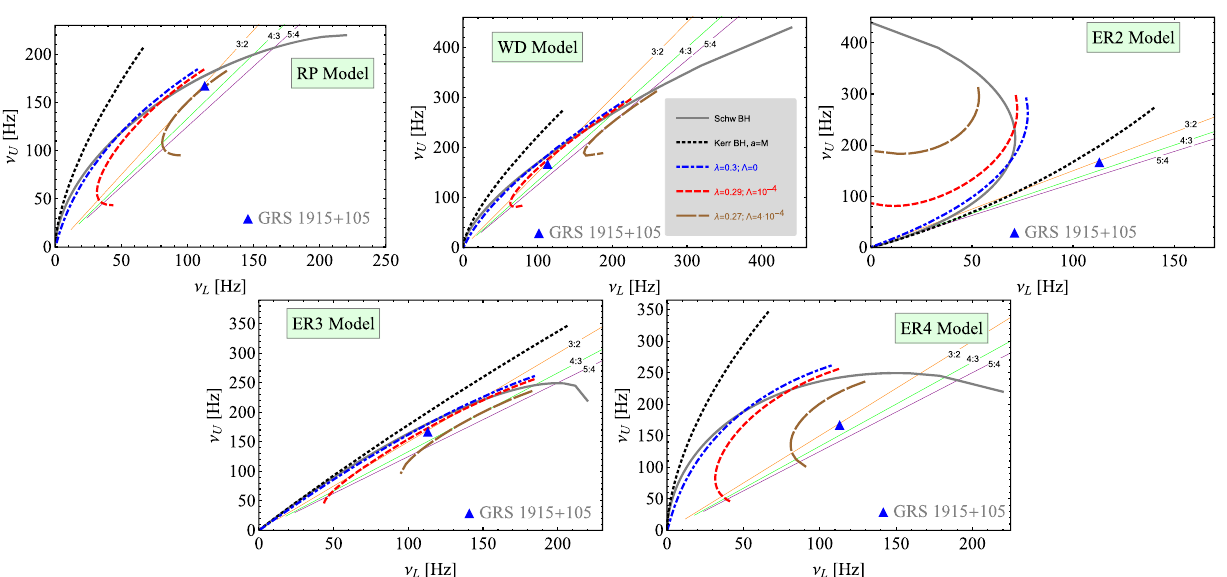
Fig. 11 Relations between frequencies of upper and lower peaks of twin peak QPOs in the RP, WD and ER2–4 models around the Schwarzschild BH, extremely rotating Kerr BH and Schwarzschild–